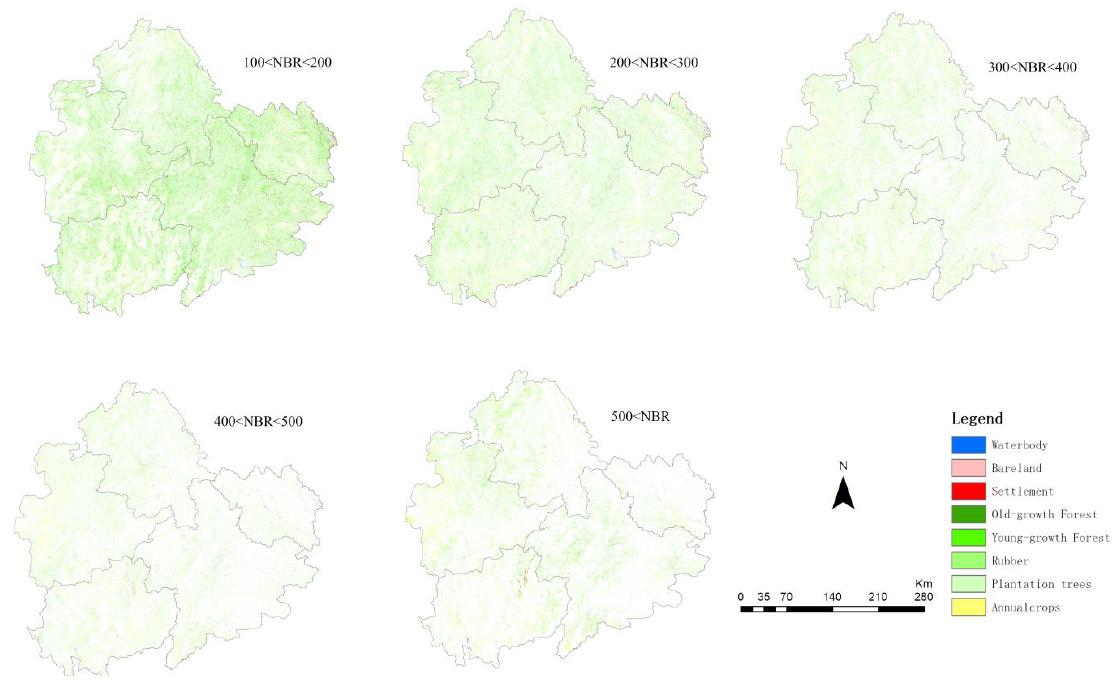
Figure 8. The spatial relationships between land use volatility and the latest land use/cover types.